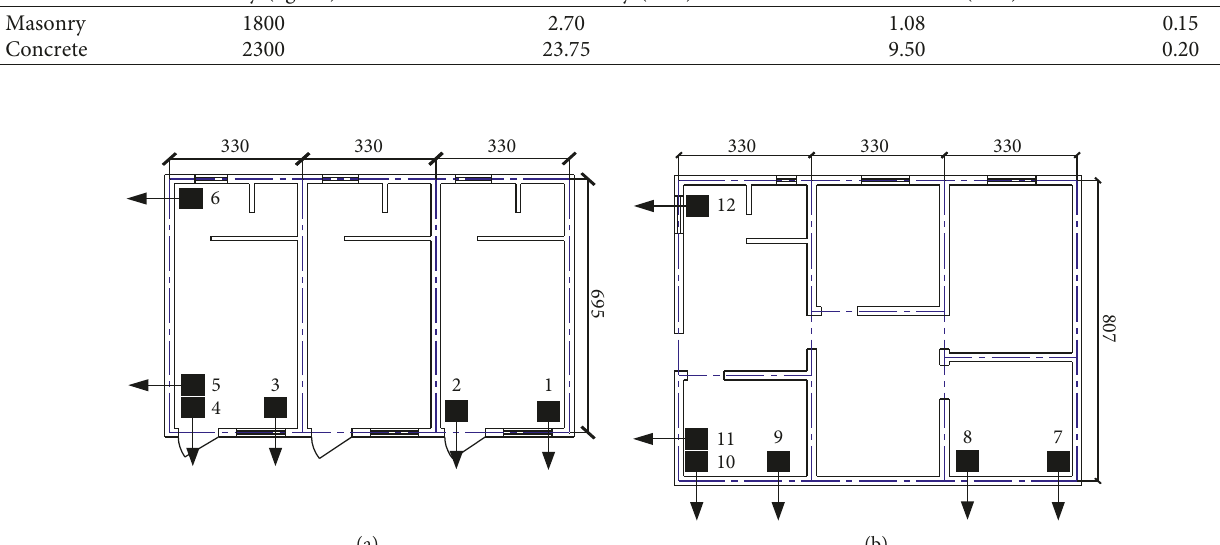
Figure 10: Schematic diagram showing the layout of the measurement points (unit: cm). (a) First floor. (b) Second floor.